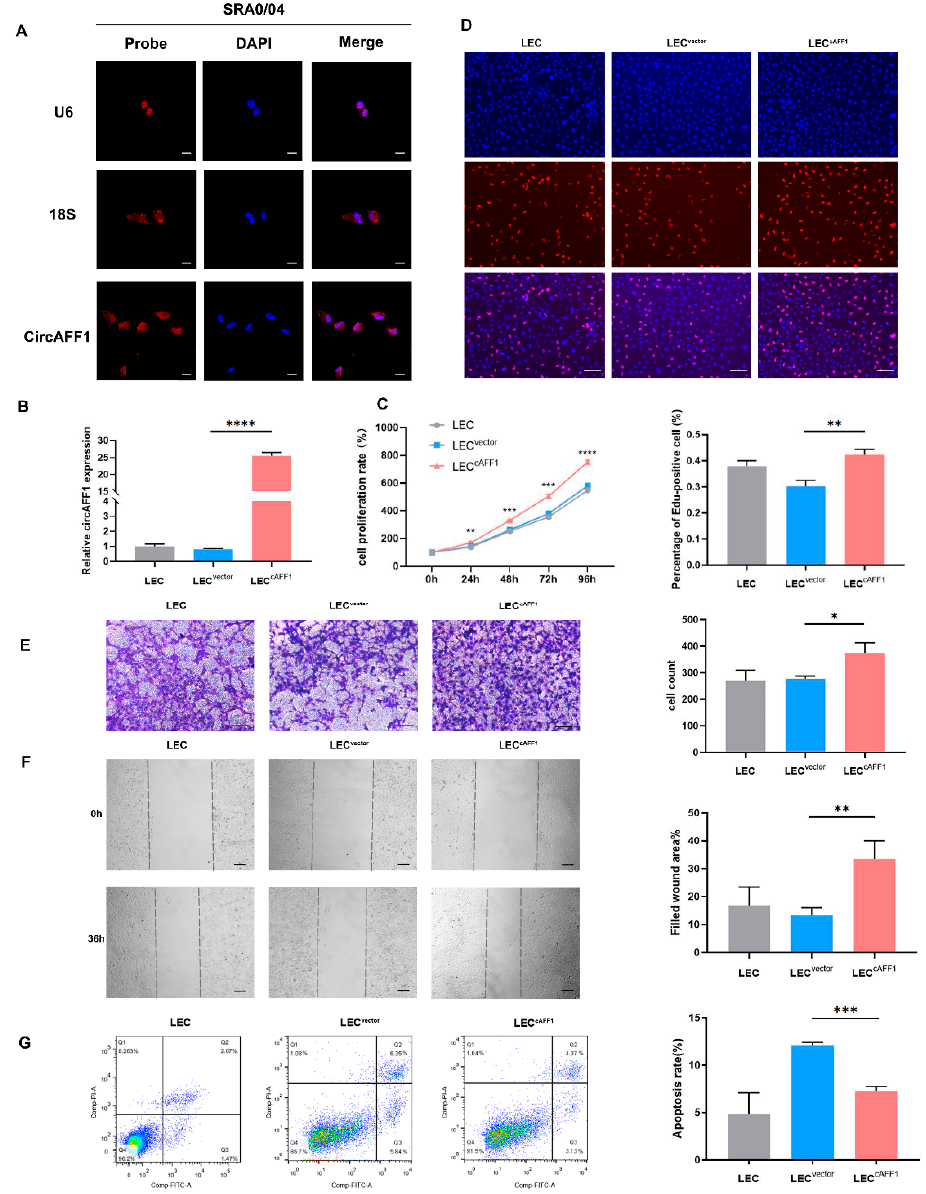
Figure 4. Overexpression of circAFF1 promoted cell proliferation, migration and inhibited cell apoptosis in LECs. ( A ) Subcellular localization of circAFF1 in LECs as determined by RNA-FISH assay. The nucleus was stained with DAPI. Scale bar: 20 µ m. ( B ) Levels of circAFF1 expression in LECs with stable transfection. ( C ) The results of CCK-8 assay showing higher proliferation rate of LEC cAFF1 than LEC vector after 24 h. n = 3, ** p < 0.01, *** p < 0.001, **** p < 0.0001. ( D ) The results of EdU incorporation showing more proliferating LEC cAFF1 than LEC vector . The quantitation of the labeled cells was shown in the panel below. n = 3, ** p < 0.01. Scale bar: 100 µ m. ( E ) Transwell assay showed increased migration of LEC cAFF1 compared to LEC vector . n = 3, * p < 0.05. Scale bar: 100 µ m. ( F ) Wound healing assay showed that the LEC cAFF1 migrated significantly faster than the LEC vector . n = 3, ** p < 0.01. Scale bar: 100 µ m. ( G ) Cell apoptosis assay showed less apoptotic LEC cAFF1 than LEC vector . n = 3, *** p < 0.001. Data were expressed as mean ±